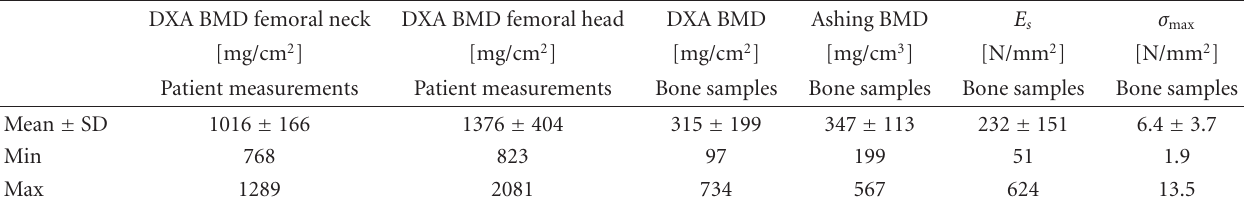
Bone samples Bone samples